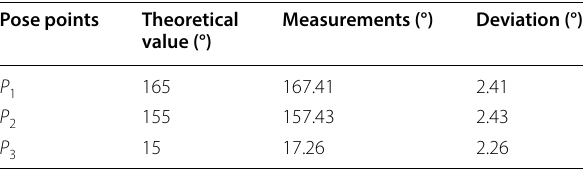
Table 5 Theoretical and practical comparison of angle values at the precise pose points Pose